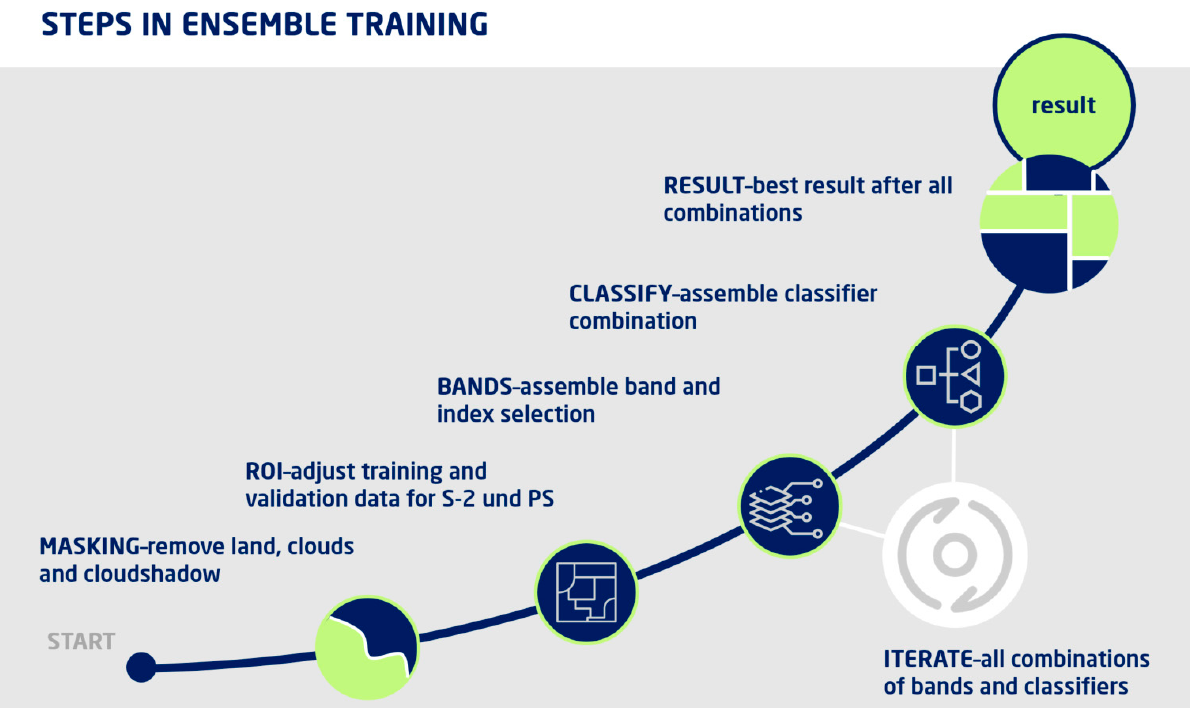
Figure 4. Iterative training of the classifiers for the ensemble with varying band/index combinations as input.